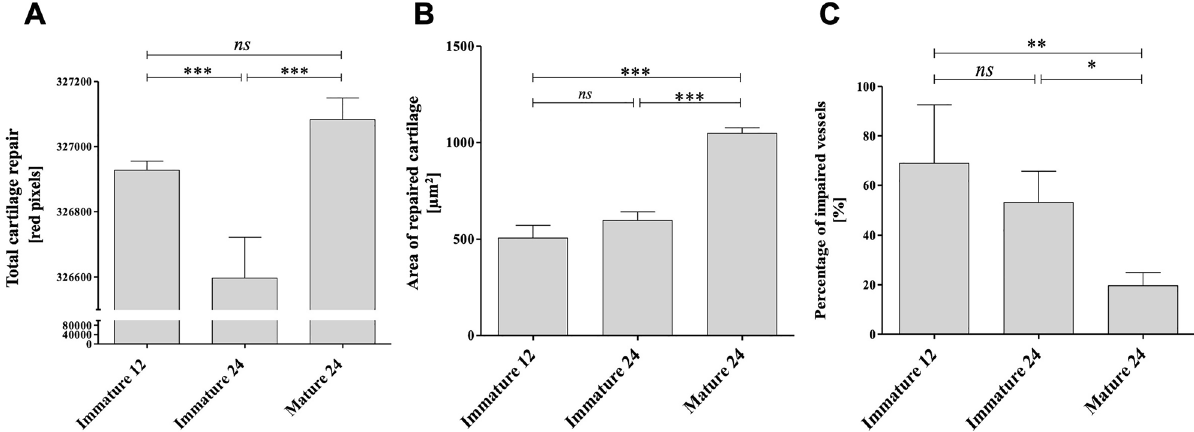
Figure 7. The comparison of total cartilage repair ( A ), the area of repaired cartilage (um 2 ) ( B ), and the percentage of impaired vessels ( C ) between immature and mature pigs after MASI. ( A ) The reduced absorbance of van Gieson dye in immature pigs was noted when compared to mature pigs. Reduced dye absorbance of van Gieson, demonstrates a limited cartilage repair and functional deterioration (***p < 0.001). ( B ) The reduced area of repaired cartilage (um 2 ) in immature pigs was noted when compared to mature pigs. The lowest area of repair for cartilage defect in immature pigs at 12 and 24 months after MASI indicating on the limited cartilage repair in immature pigs (***p < 0.001). ( C ) Representative data from randomized, twelve fields are shown ± SD (n = 12). An asterisk (*) indicates a comparison between all of the tested groups (*p < 0.05, **p < 0.01). SD standard deviation, ns not